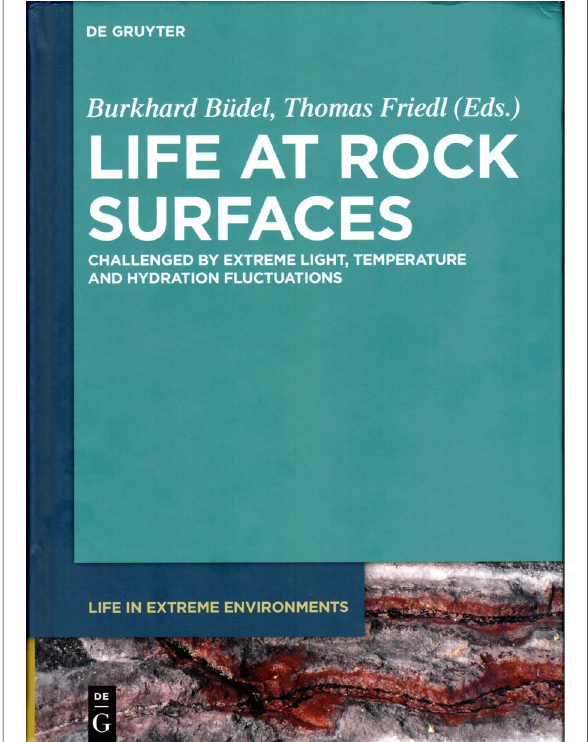
Fig. 33 Life at Rock Surfaces